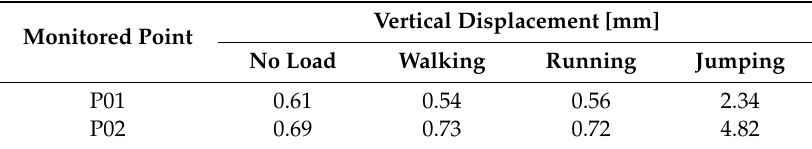
Table 3. Maximum vertical displacements obtained by